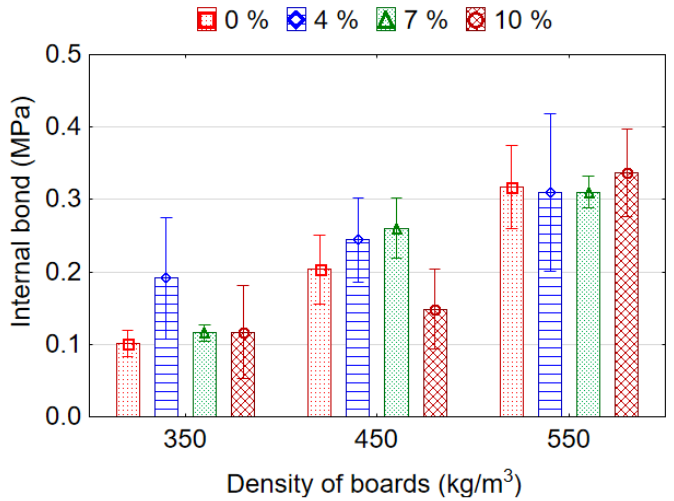
Figure 6. The internal bond strength of the lightweight particleboards. Table 3. Some properties of lightweight veneered particleboards compared to the CEN/TS 16368 standard.